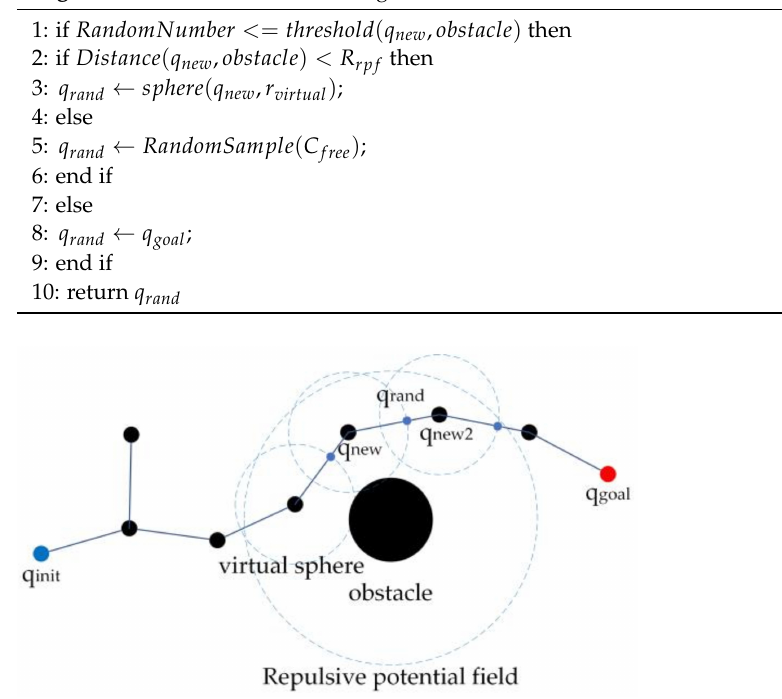
Algorithm 4. Node-First Search Algorithm.